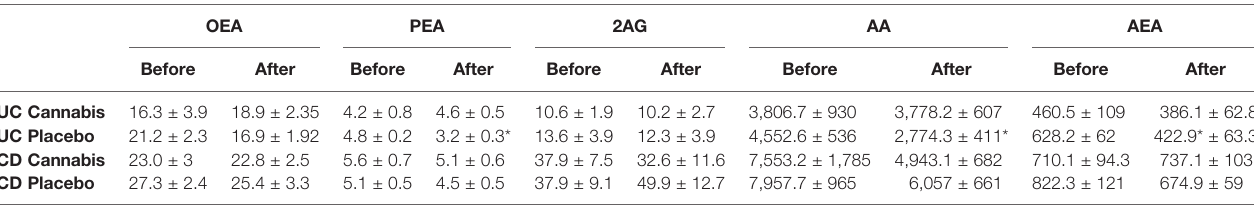
TABLE 6 | Effect of cannabis on eCB levels. OEA PEA Before After Before